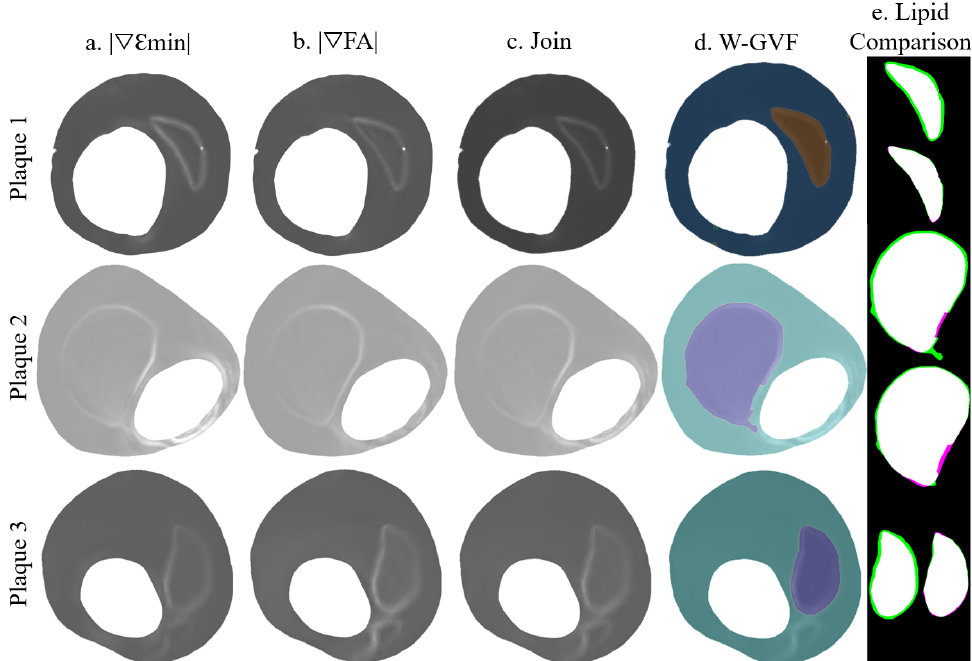
Figure 7. Segmentation procedure in the IVUS geometries with clean strains. The rows represent the segmentation process with the plaques 1, 2, and 3; ( a ) representation of |(cid:53) ε min | ; ( b ) representation of |(cid:53) FA | ; ( c ) the combination of |(cid:53) ε min | + |(cid:53) FA | ; ( d ) W-GVF results; and ( e ) segmented lipid before and after the smooth treatment, where the true positive area is in white, the false negative area in green and the actual area that is not segmented in purple.